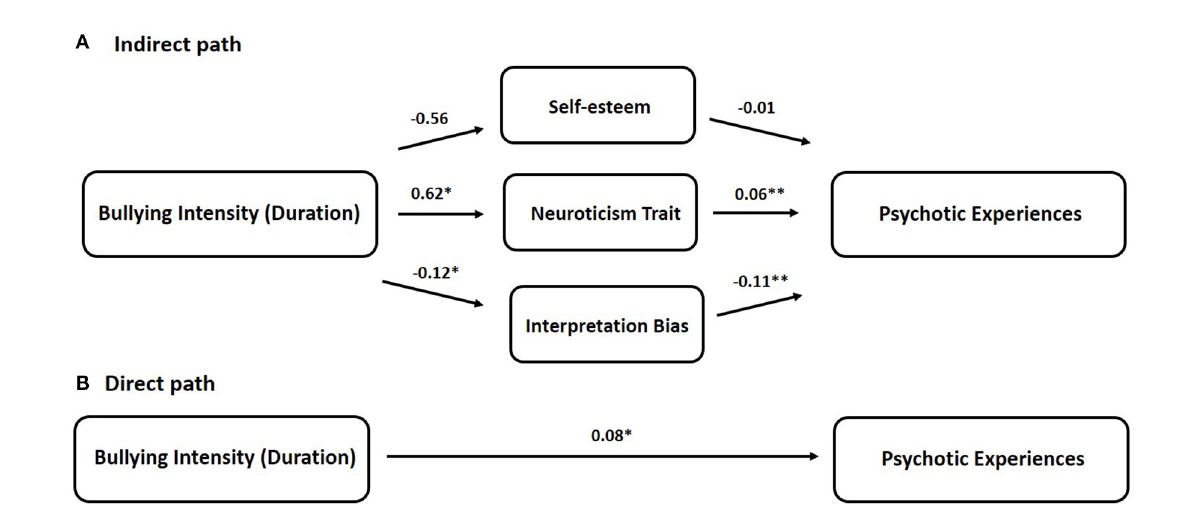
FIGURE2 The multiple mediator model for bullying intensity (Duration) on psychotic experiences. (A) Indirect path and (B) direct path. Unstandardized coefficient ( b ) presenting the effect of school bullying on mediators and Psychotic experiences (PE). Significant effects were found for the total effect ( p = 0.0001) and direct effect ( p = 0.016) of bullying intensity (duration) on PE scores. The multiple-mediator model accounting for 16.47% of the variance in PE scores [ F (4,257) = 9.38, p < 0.001]. *Significant at p < 0.05, **Significant at p <